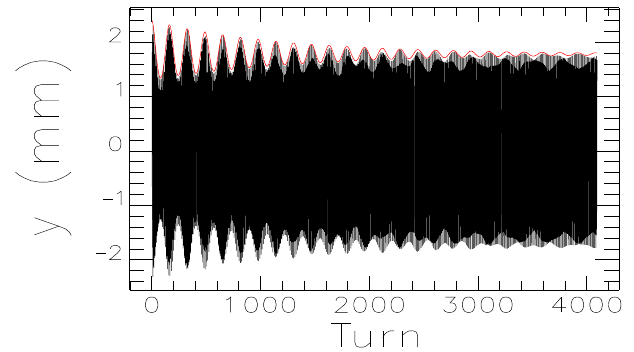
FIG. 1. (Color) Vertical decoherence due to longitudinal diffu- (cid:3) 3 : 5 , (cid:2) (cid:3) 0 : 0078 , (cid:7) (cid:3) 9 : 6 (cid:8) sion. The parameters are C y s (cid:5) (cid:3) 1 : 2 (cid:8) 10 (cid:2) 4 . The red envelop is given by Eq. (9) 10 (cid:2) 4 , and a E FIG. 2. (Color) The side views of a bunch at turn 63 to 67 after a vertical